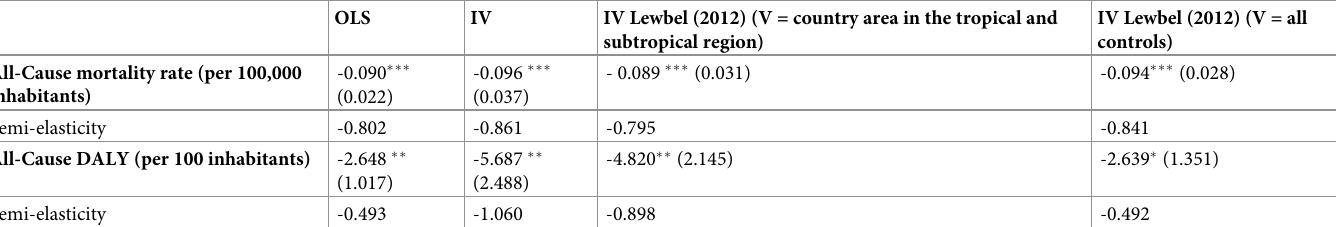
Table 4. The effect of mortality/DALYs on GDPpc growth. Long-Run Growth Regression estimated adding Lewbel’s (2012) heteroskedasticity based